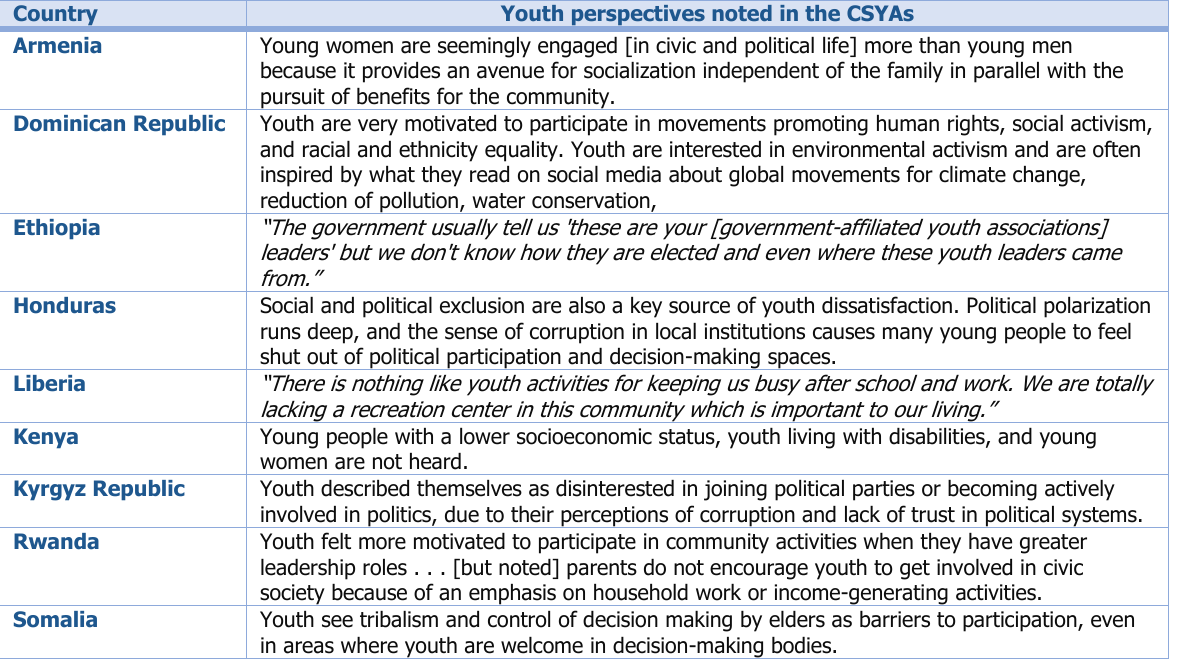
Table 10. Youth Perspectives on Civic